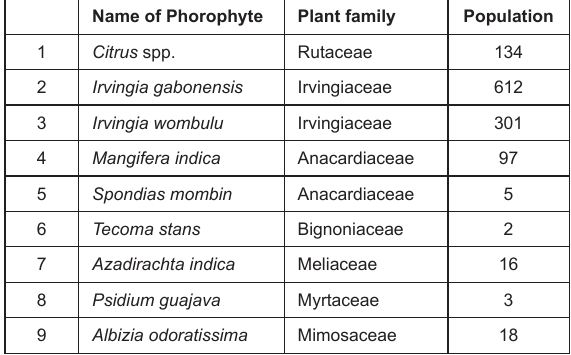
Table 2. Phorophytes population in the NACGRAB Field Gene bank